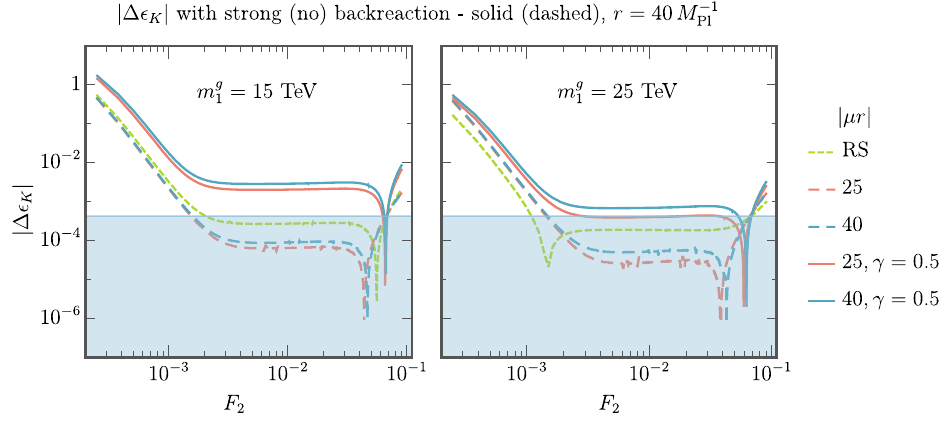
µr and considering strong | |